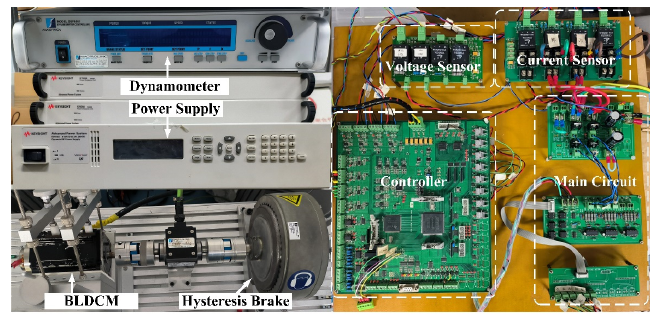
Figure 8. Experimental system.